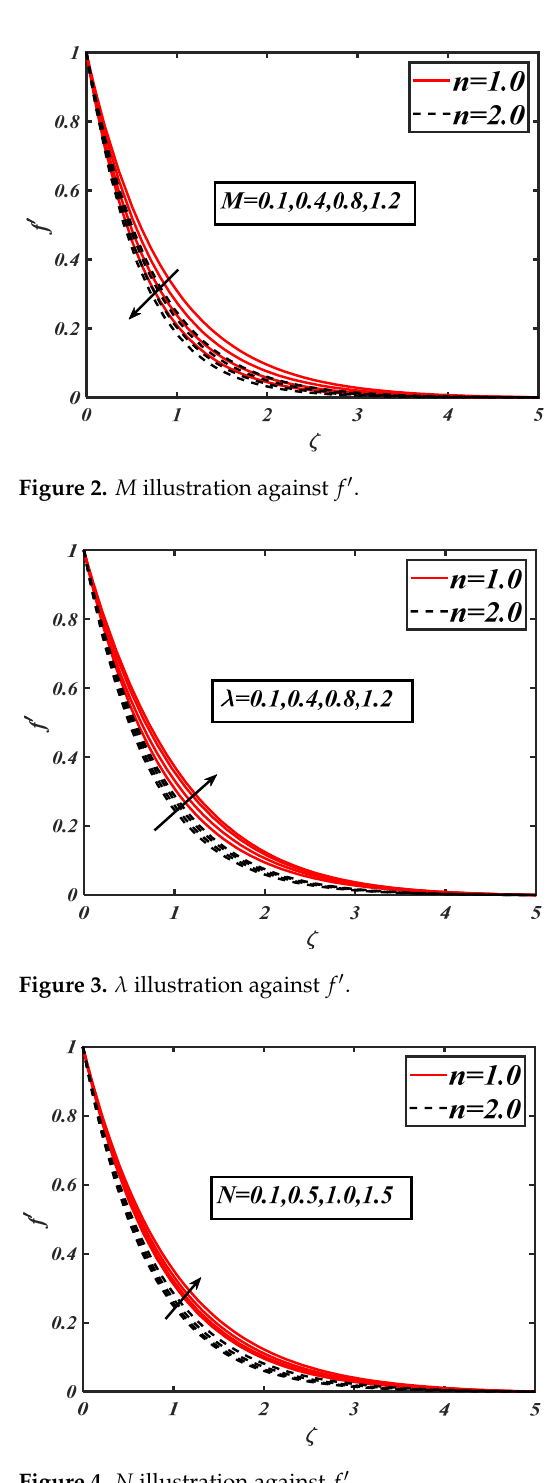
Figure 4. N illustration against f (cid:48)